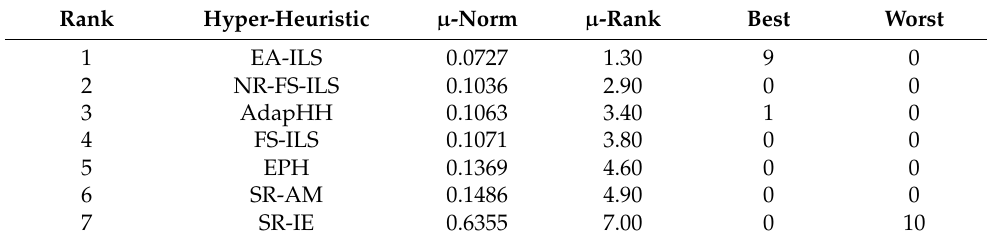
Table 6. Evaluation Results on the Quadratic Assignment Problem.